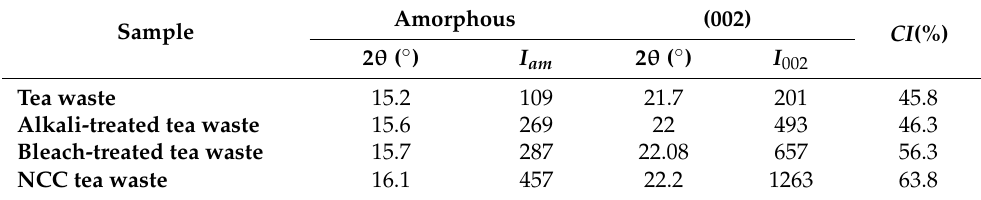
Figure 6. XRD diffractograms of ( a ) the chemical treatment process of tea waste and ( b ) PVA–NCC nanocomposite films. Table 2. The crystallinity index of tea waste at different stages of chemical treatment.